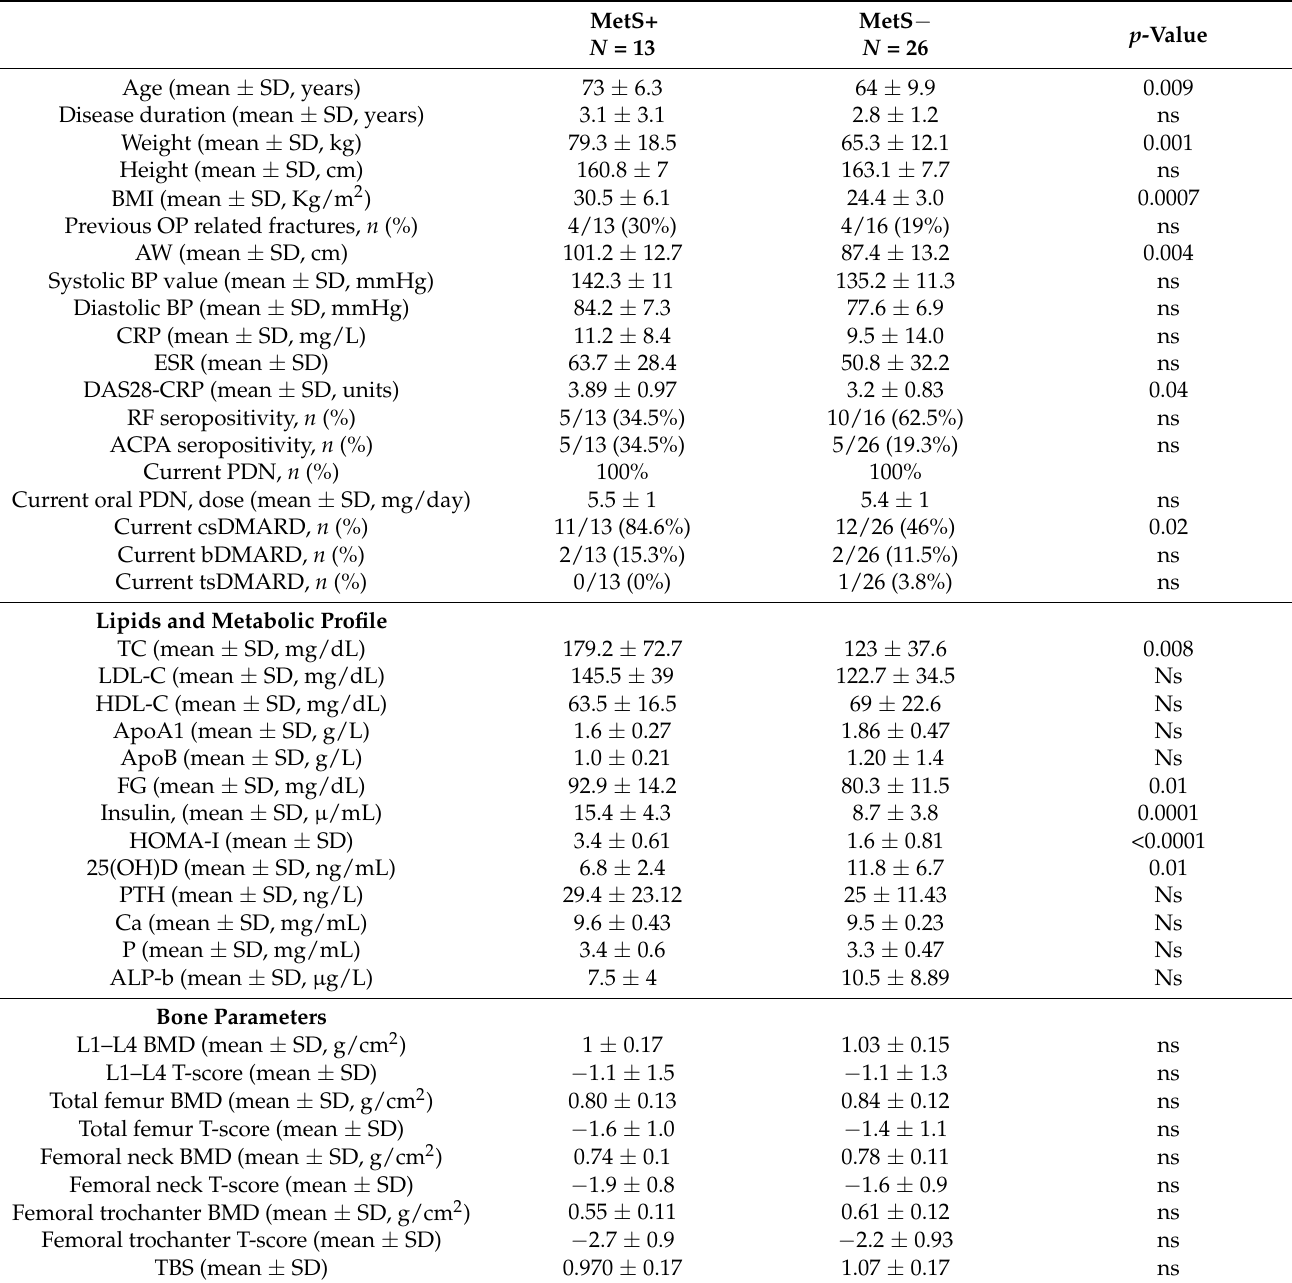
Abbreviations: see the legend of Table